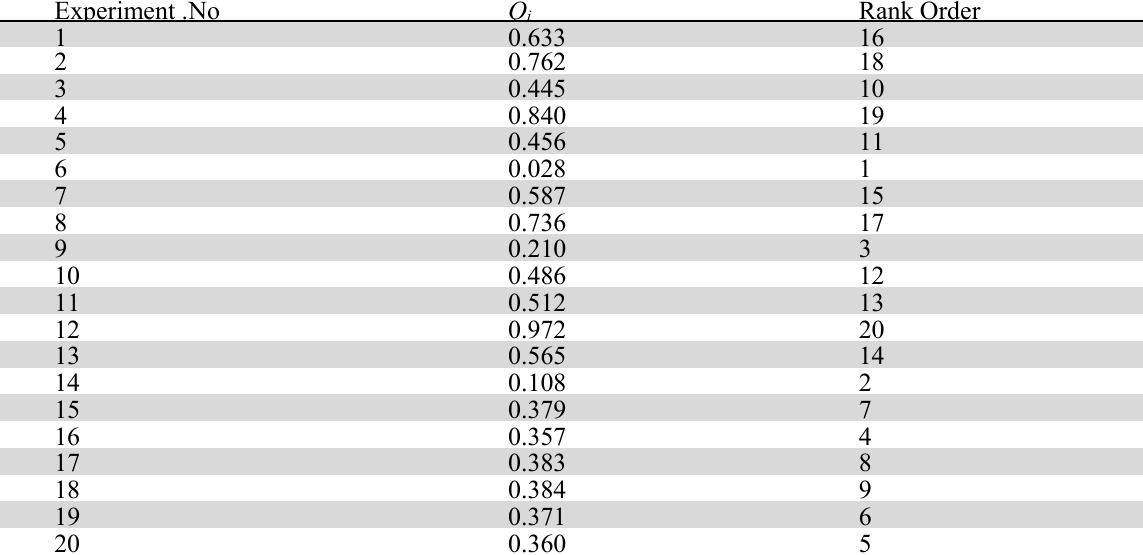
VIKOR Index ( Q i ) scores and Rank Order.